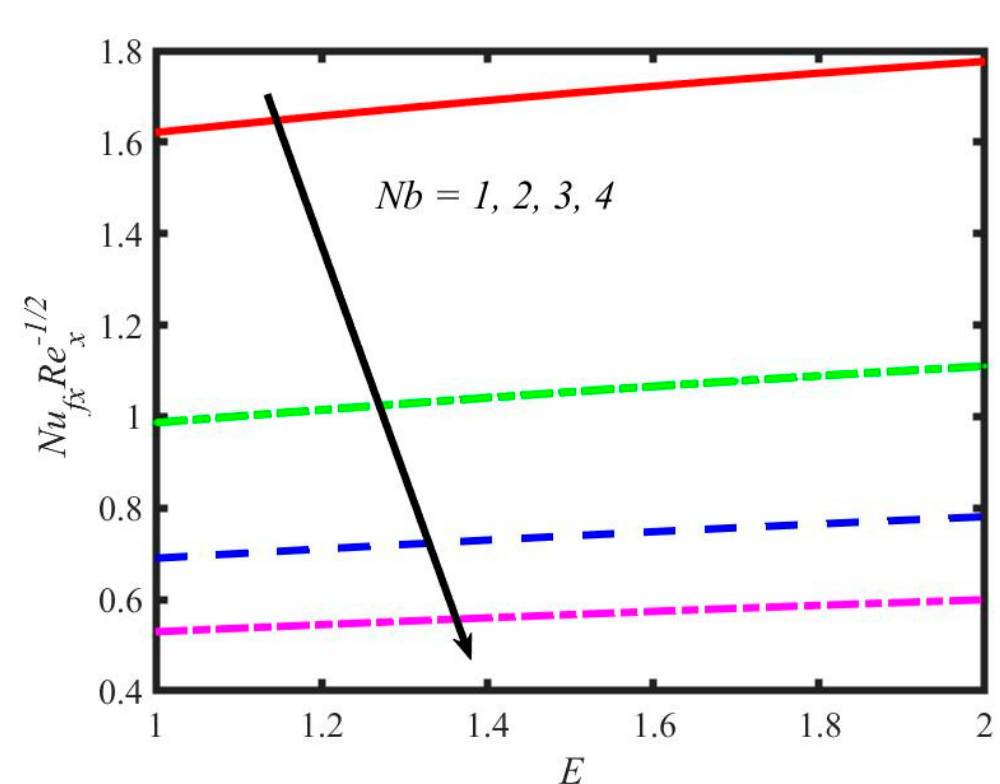
Figure 30. Variations in local Nusselt number for Brownian motion parameter.